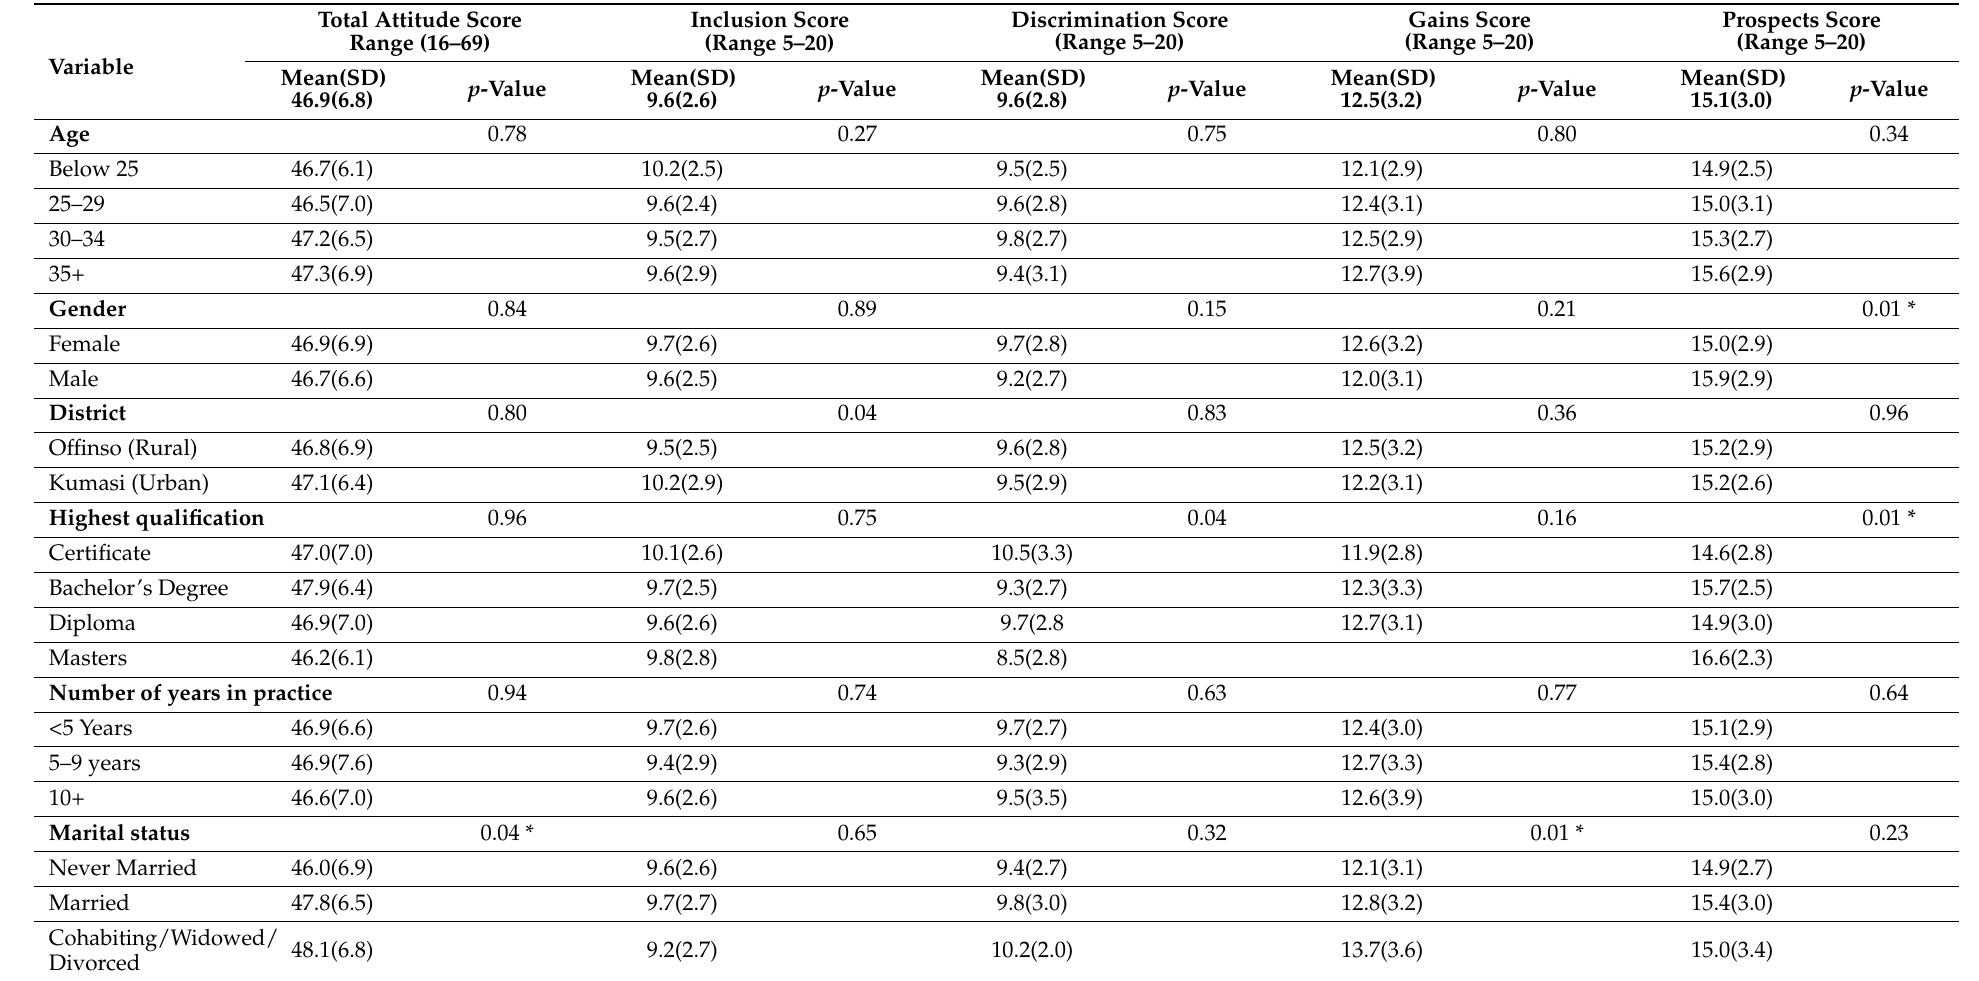
Table 2. Factors influencing the attitude of healthcare providers towards persons with